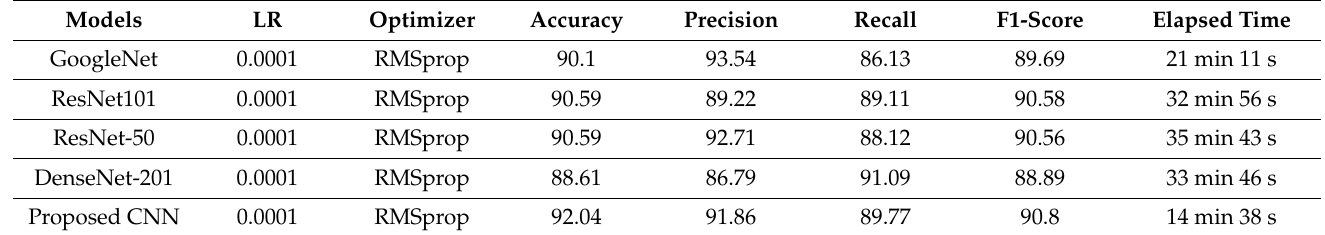
Table 9. Comparative analysis with existing CNN models.